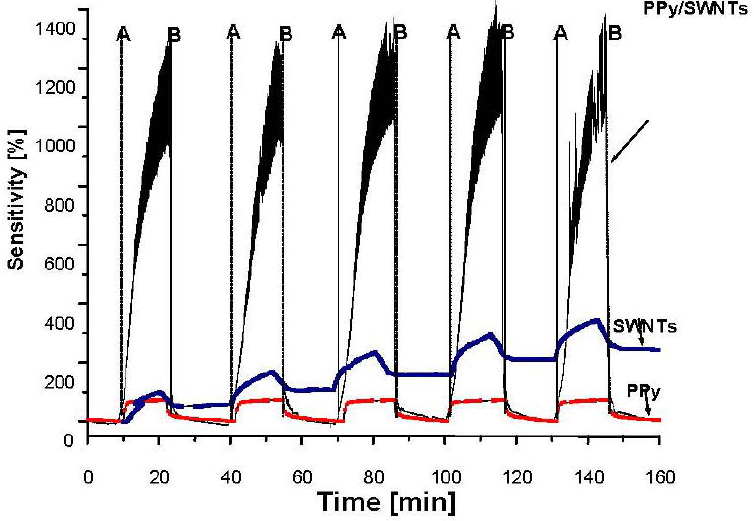
Figure 7. NH sensitivity of PPy, SWNTs and PPy/SWNTs upon exposure to 750 ppm 3 NH . (A: NH on, B: NH gas 3 3 3